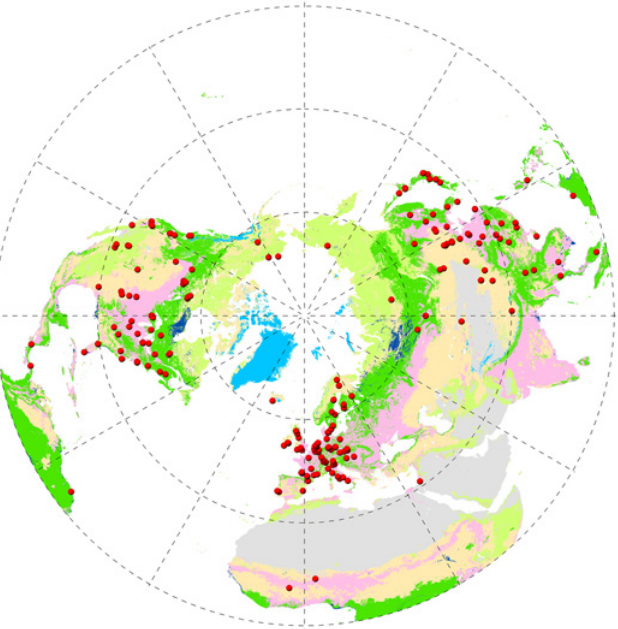
Fig 1. Spatial distribution of eddy covariance flux sites used in this study. Red circles indicated the locations of eddy covariance flux sites in the Northern Hemisphere. The base map was the 2008 MODIS (Moderate-resolution Imaging Spectroradiometer) land-cover product (MCD12C1) at a spatial resolution of 0.05 degree plotted by the North Pole Azimuthal Equidistant projection tool in ArcGIS 10.0